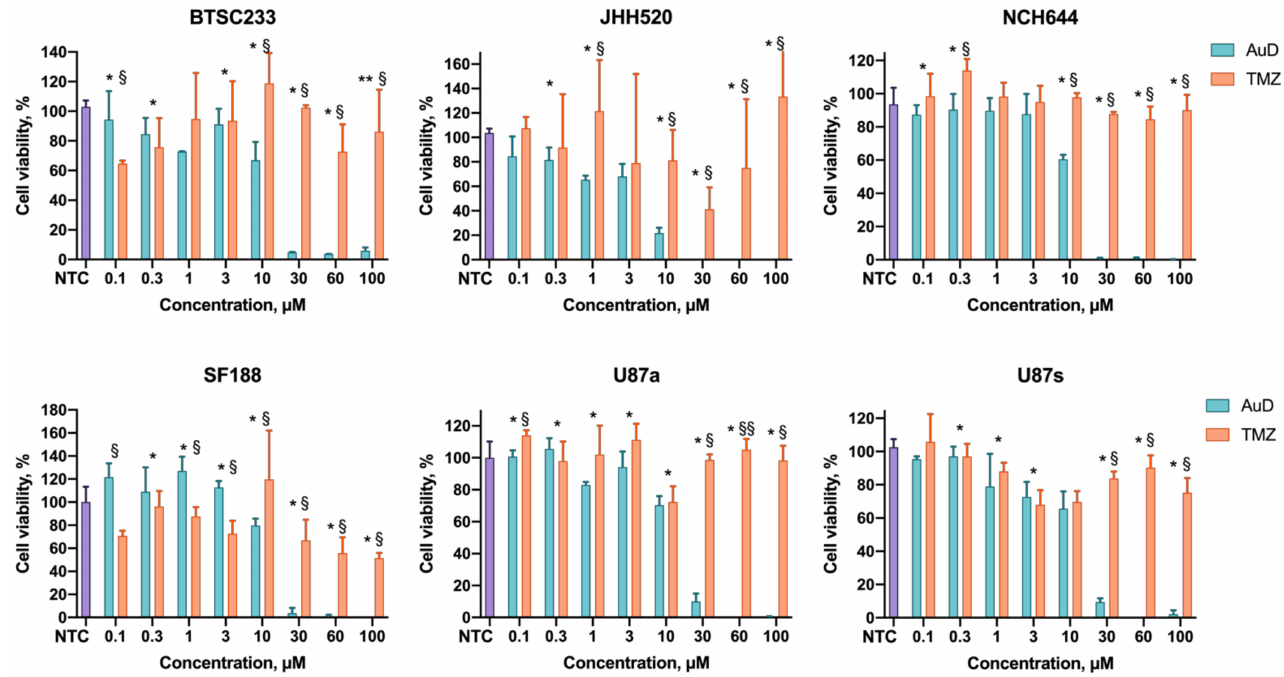
Figure 4. Profiles of the cell viability (MTT assay) after incubation with AuD metallodendrons and temozolomide (TMZ). NTC—non-treated control. Data are presented as mean ± S.D. * p < 0.05, ** p < 0.01 CuD vs. AuD; § p < 0.05, §§ p < 0.01 AuD vs.